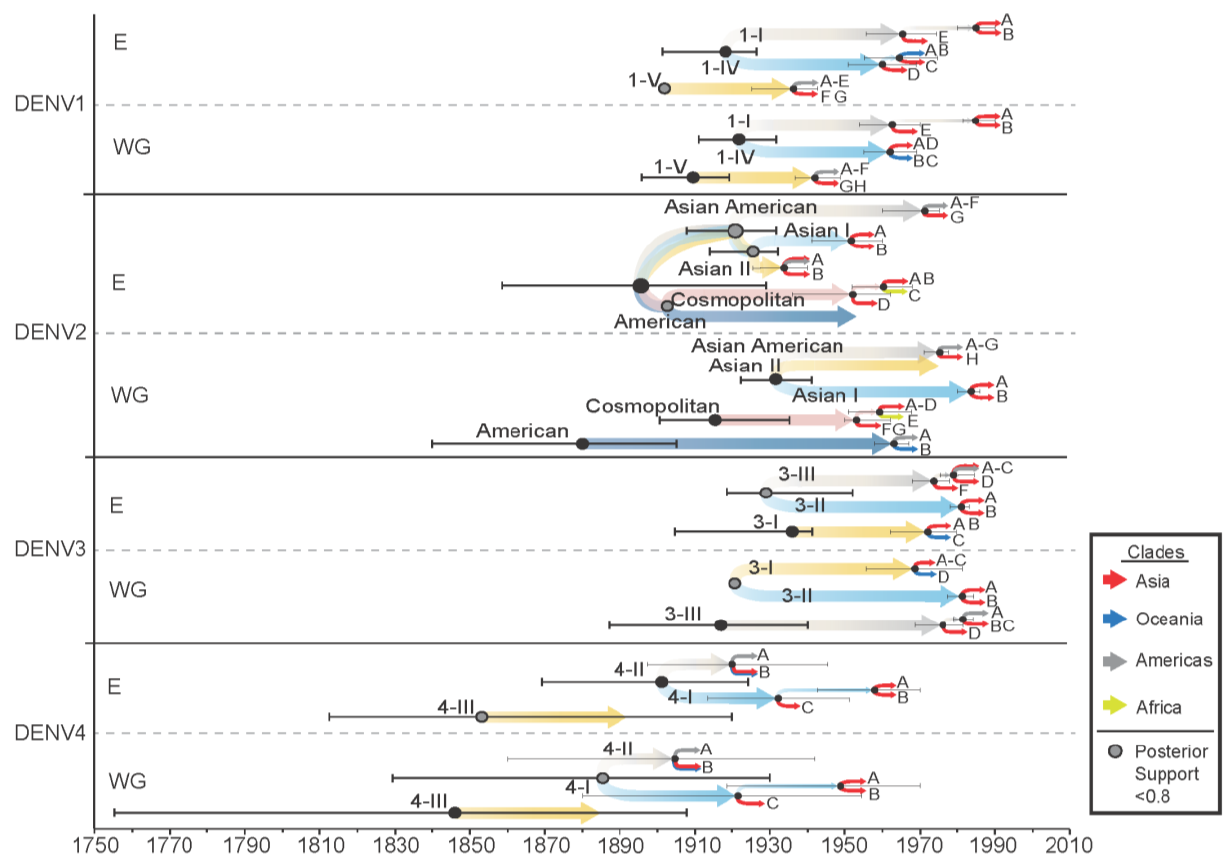
Figure 5. Genotype and major clade diversification date estimates and 95% HPD for the whole genome (WG) and E gene (E) for each serotype. Divergence nodes with posterior probability support <0.8 are represented by a grey dot with a black outline. Major clades are denoted by clade letter as indicated on Supplementary Figures S9, S11, S13 and S15 and colour coded by region.